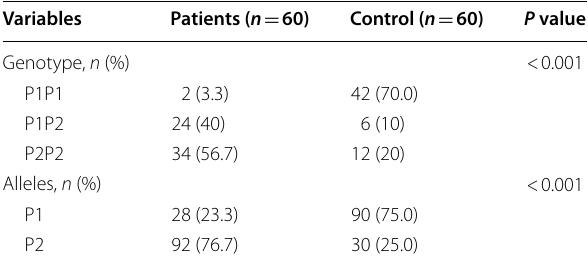
Table 2 Genotype and allele frequencies of IL4 in patients with AML and controls